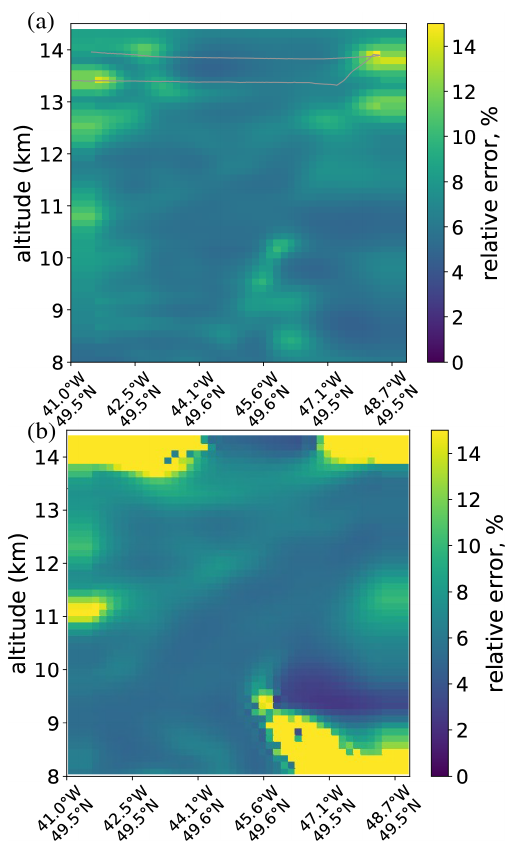
Figure B1. 3-D tomography relative error, Monte Carlo estimate: (a) ozone; (b) nitric acid.